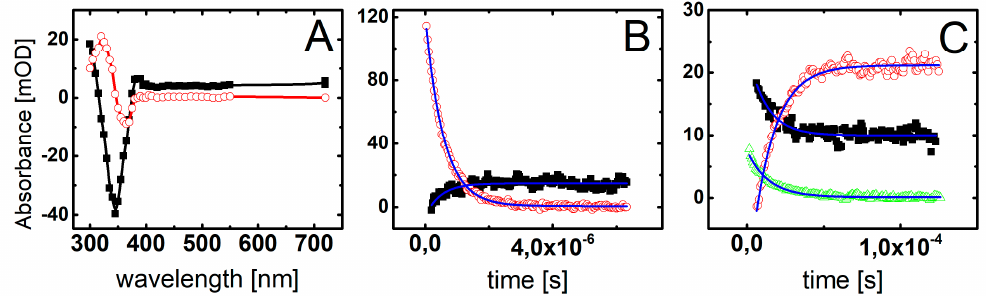
Figure 4. ( A ) Transient absorption spectra recorded in deoxygenated and buffered with phosphate (10 mM, pH = 7.0) ISdU solution (5 · 10 − 5 M), in the presence of 0.5 M t -BuOH, after 2 μ s ( ■ ) and 120 μ s ( ) after the electron pulse. ( B ) Short-time profiles representing the growth at λ = 305 nm ( ■ ) and the decay at λ = 720 nm ( ) of transient absorptions and their least-square fits to the first order formation and decay, respectively. ( C ) Long-time profiles representing the growth at λ = 320 nm ( ) and decays at λ = 300 nm ( ) and λ = 385 nm ( ■ ) of transient absorptions and their least-square fits to the first order formation and decays, respectively.